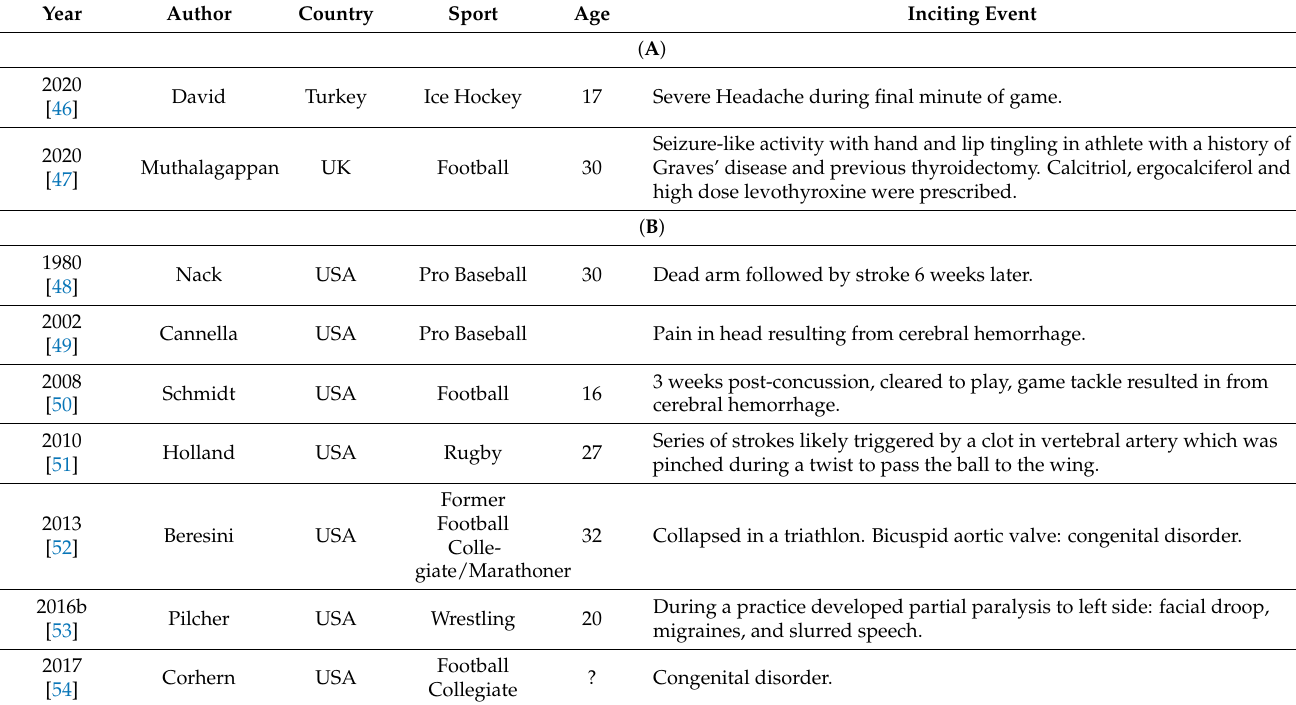
high dose levothyroxine were